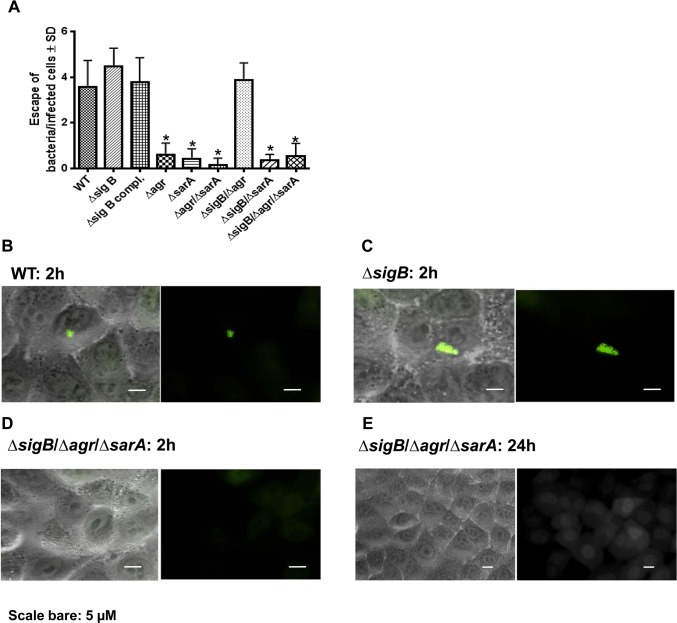
Phagosomal escape of wild-type strain LS1 and corresponding mutants after infection of the host cell construct A549YFP-CWT.Phagosomal escape was measured 2 hours (A, B, C, D) and 24 hours (E) after infection with the strain LS1 or corresponding mutants in genetically engineered A549 cells. This reporter recruitment technique has been recently described [13]. To quantify the phagosomal escape for each strain 10 fields of view were evaluated respectively and the numbers of escaping bacteria were counted. The values represent the mean ± SD of 5 independent experiments measured.* P≤0.05 ANOVA comparing levels of gene expression in the acute and chronic stage.